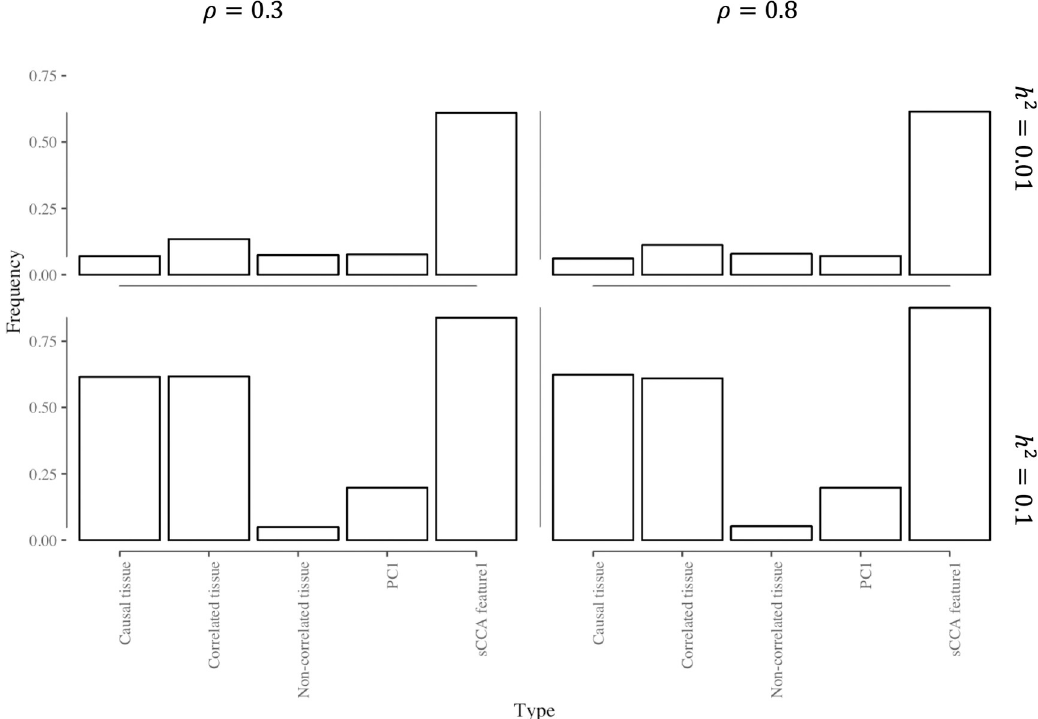
Fig 2. Proportion of significant (p < 0.05) heritability tests for different expression features when cis genetic variation is associated with expression in some tissues. Here ρ denotes the strength of the genetic correlation between expression in the causal tissue and another tissue in which the expression is also associated with cis-germline variation ("correlated tissues"). "Non- correlated tissues" are the tissues where local germline variation is not associated with the gene expression. Here expression in half of the tissues is genetically correlated with that in the causal tissue, and the causal tissue is not observed (performance in the causal tissue is included as a reference). PC1 is the first principal component of cross-tissue gene expression; sCCA-feature1 is the linear combination of tissue expression values from the first pair of sCCA canonical variables. h 2 denotes the proportion of expression variance in the causal tissue explained by cis-genetic variation.